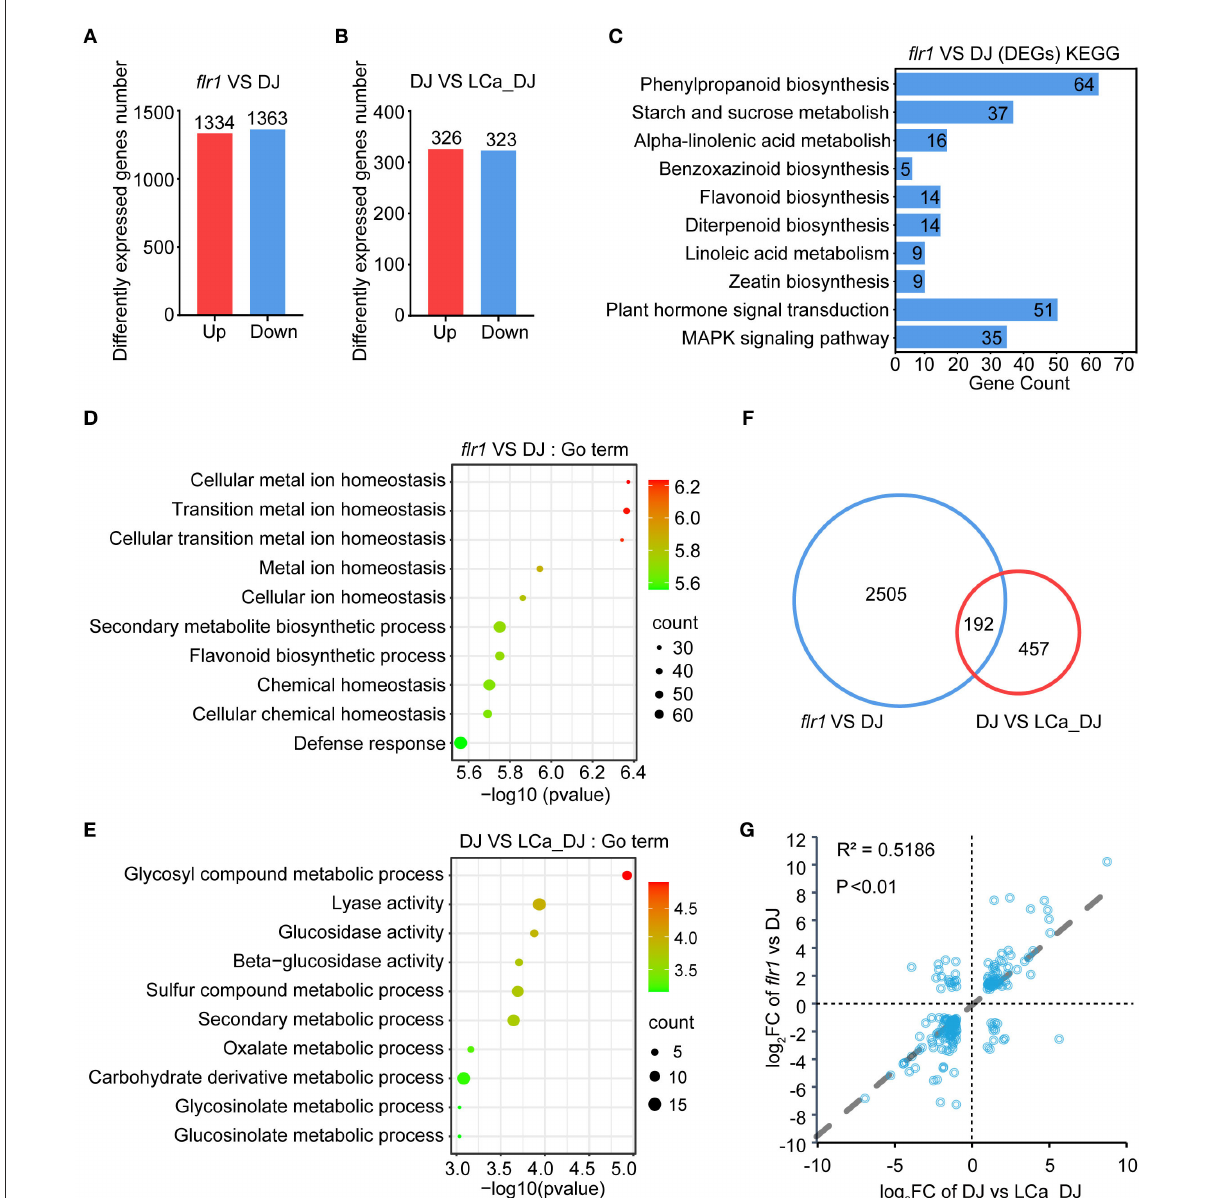
FIGURE5 Transcriptome sequencing analysis of DJ and flr1 plants. (A,B) Details of DEGs with a fold-change > 2 ( P < 0.05) in the flr1 mutant and LCa_DJ. (C) KEGG pathways that were enriched among flr1 mutant DEGs. (D,E) Top 10 components from GO enrichment analysis of DEGs ranked by p -value ( P < 0.05) in the flr1 mutant and LCa_DJ. (F) A Venn diagram of the DEGs of flr1 compared to DJ and of DJ compared to LCa_DJ. (G) Correlation analysis of the intersection of two sets of DEGs.